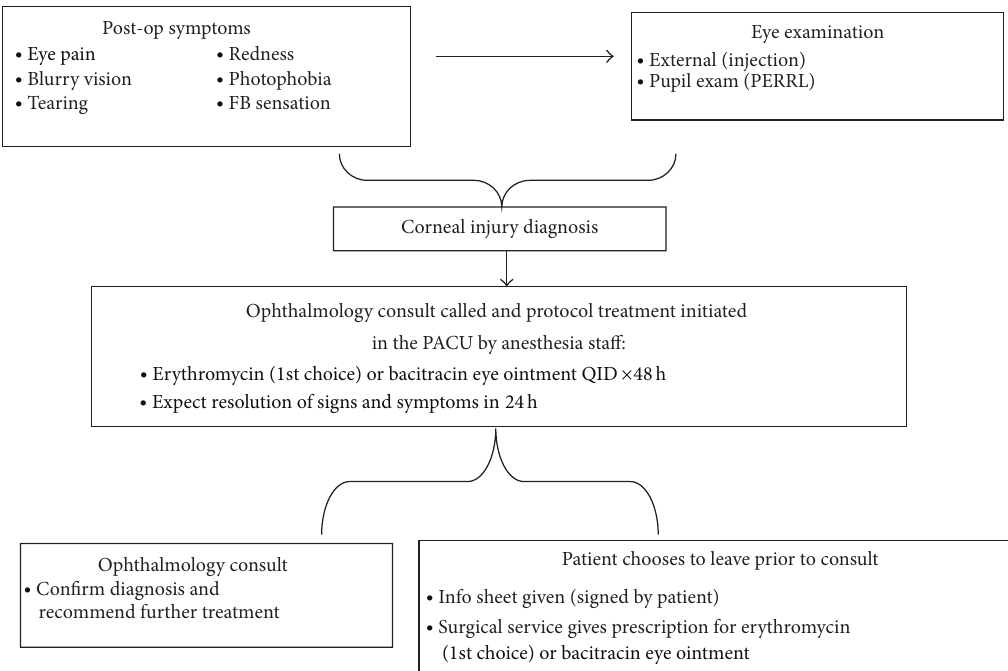
Figure 1: Corneal abrasion treatment